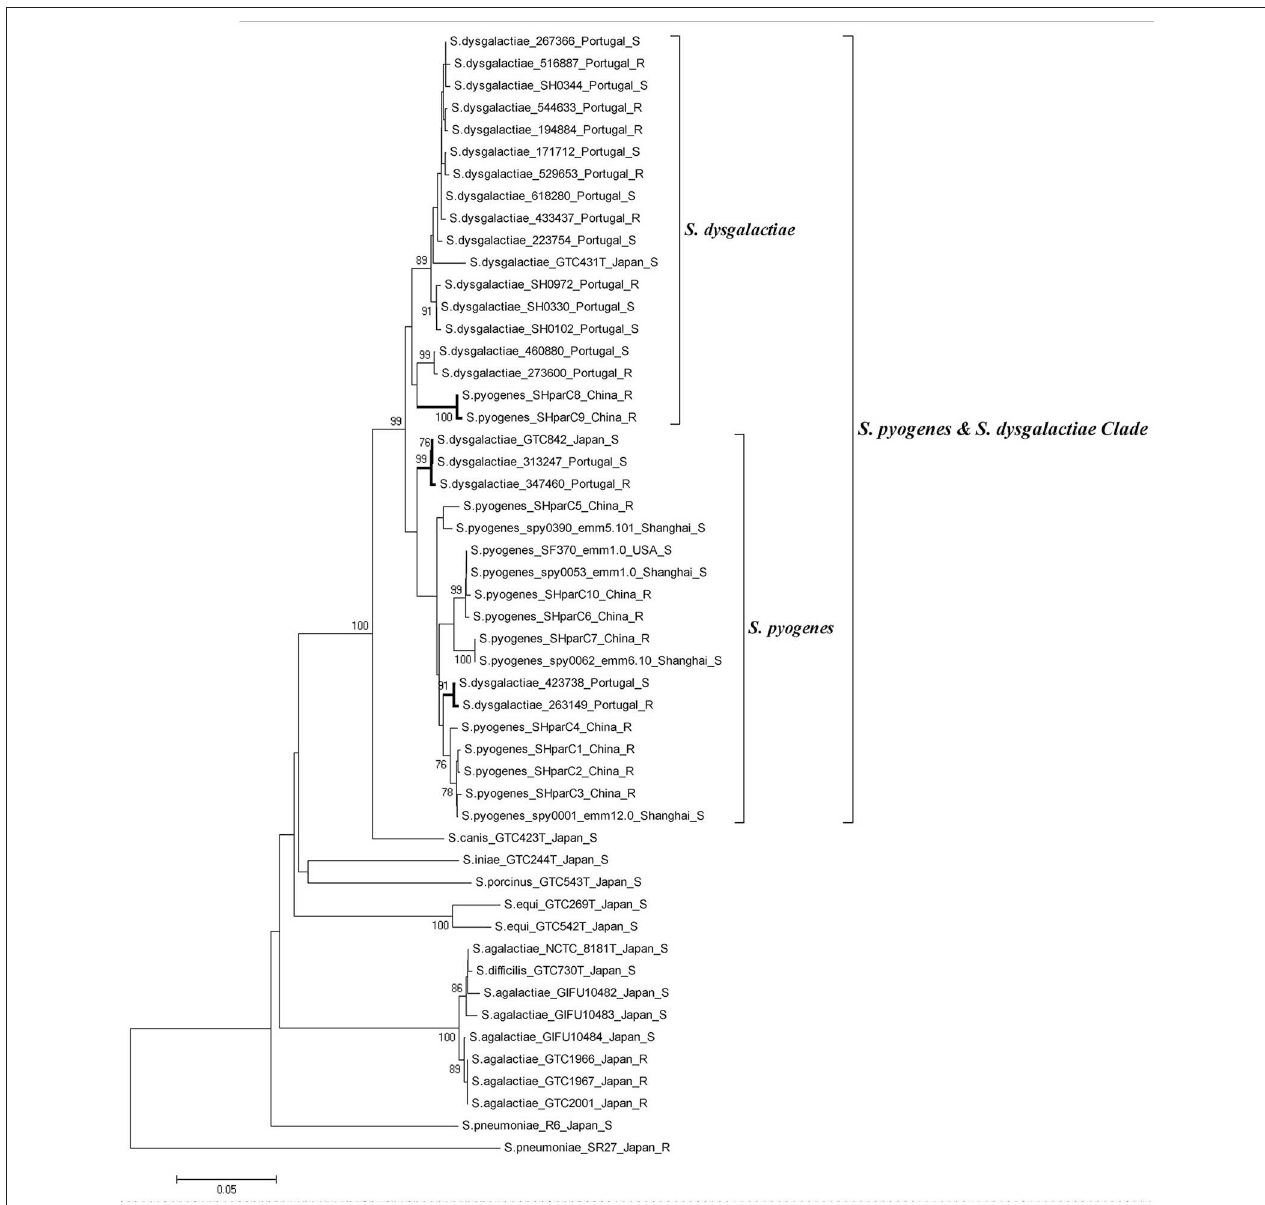
FIGURE 3 | Phylogenetic analysis of parC quinolone-resistance-determining region from different streptococcal species. Strains are shown as; species, strain number or parC allele; ( emm type); country or district; and fluoroquinolone susceptibility. All fluoroquinolone-non-susceptible isolates were labeled with “R.” Phylogenetic analysis was conducted in MEGA 5 using Neighbor-joining. Bootstrap values are indicated when support is > 75% (from 1,000 replicates). The tree is drawn to scale, with the branch lengths being in the same units as those of the evolutionary distances used to infer the phylogenetic tree. The evolutionary distances were computed by the Kimura two-parameter method and are in the units of the number of base substitutions per